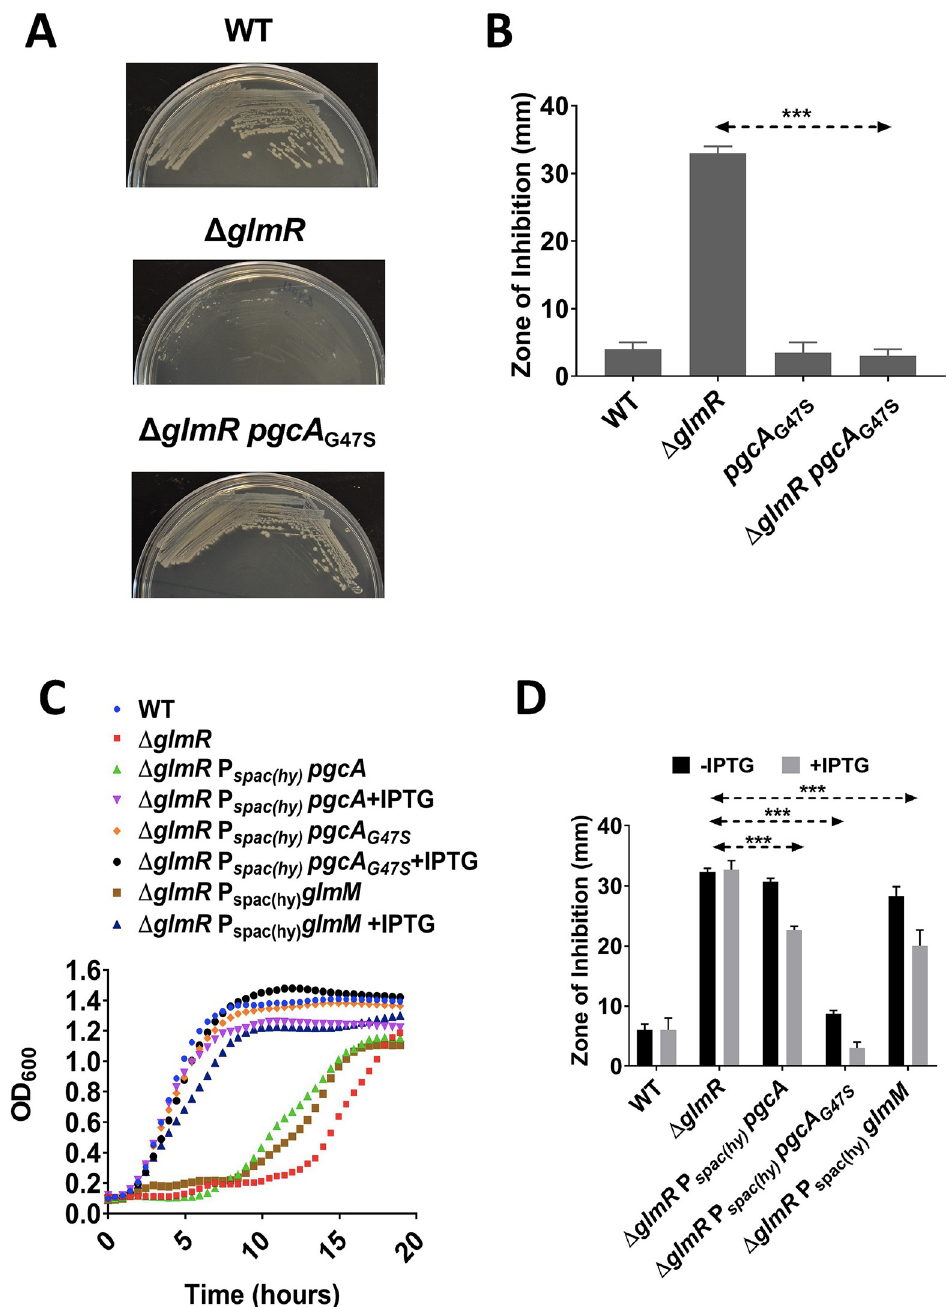
Fig 3. pgcA G47A is a gain of function mutation. (A) Representative pictures showing growth of WT, Δ glmR , Δ glmR pgcA G47S on MH and (B) Bar graph showing CEF sensitivity. pgcA and pgcA G47S were ectopically expressed at amyE in Δ glmR and Δ glmR Δ pgcA and tested for (C) growth on MH medium (representative growth curves are shown; N > 3) and ( D ) CEF sensitivity by disk diffusion assay using 6 μ g CEF per disk. Where indicated, 1 mM IPTG was added. Standard deviation (error bars) is based on at least three biological replicates. Three asterisks represent statistical significance with P < 0.001 with Tukey